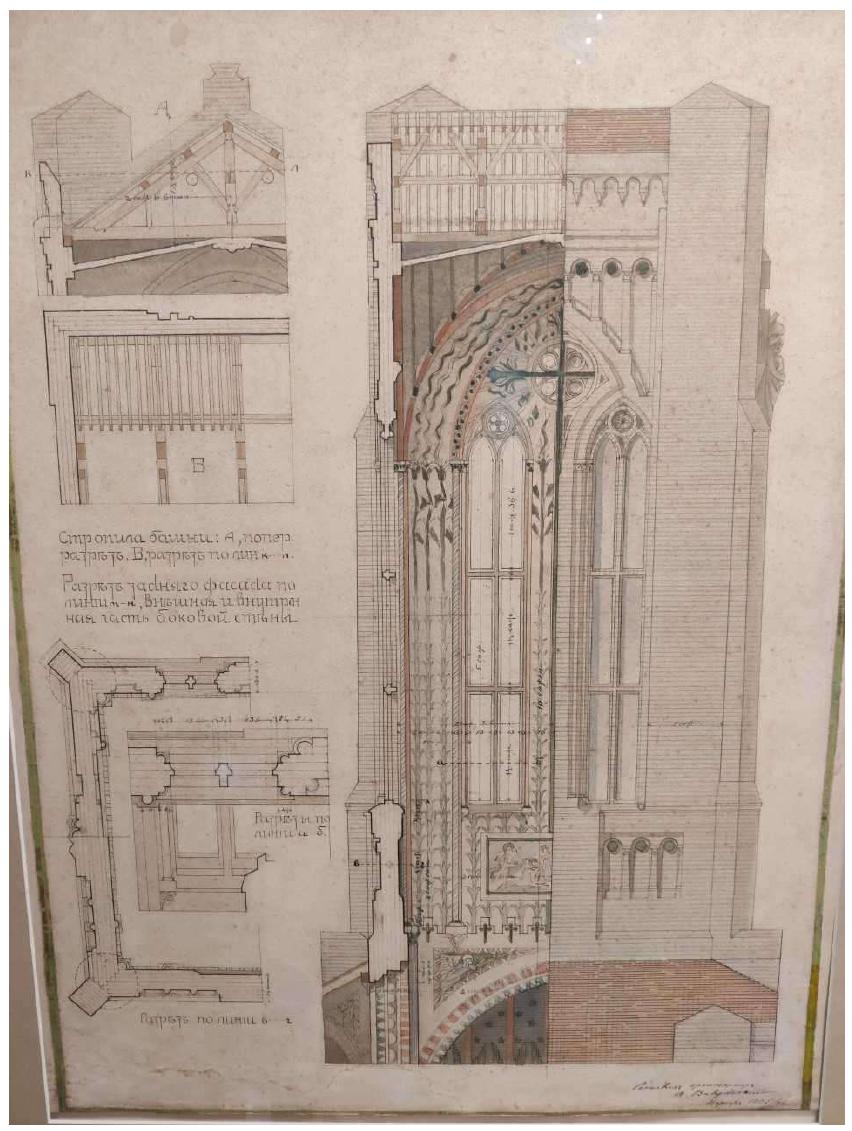
Figure 8. A photo of an authentic drawing of the Chapel of the Apparition of Saint Mary. Antanas Vivulskis (Antoni Wiwulski), 1905.